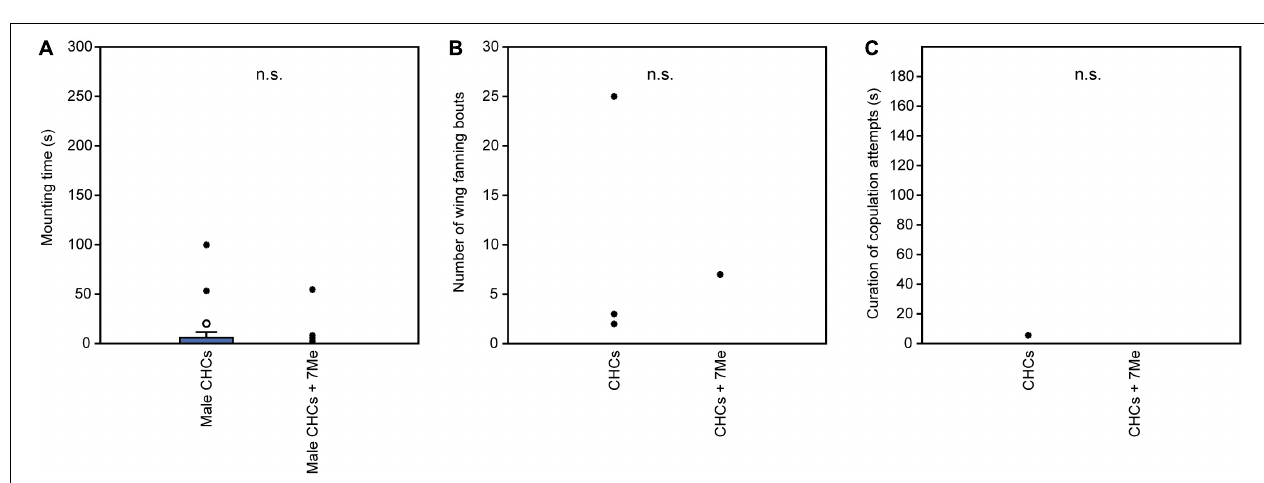
FIGURE 5 | Behavioral responses of U. rufipes males to Soxhlet-extracted male cadavers (dummies) treated with male-derived cuticular hydrocarbons (CHCs) purified by silica gel chromatography or a subfraction supplemented with synthetic 7-MeC31 and 7-MeC33. Given are (A) the time males spent mounted on the dummy, (B) the number of wing-fanning bouts, and (C) the duration of copulation attempts. Box-and-whisker plots show median (horizontal line), 25–75% quartiles (box), maximum/minimum range (whiskers) and outliers ( ◦ > 1.5 × box height; • > 3 × box height; Mann-Whitney U -test; n.s. = not significant; n = 25). Statistical results are given in detail in Supplementary Table S4